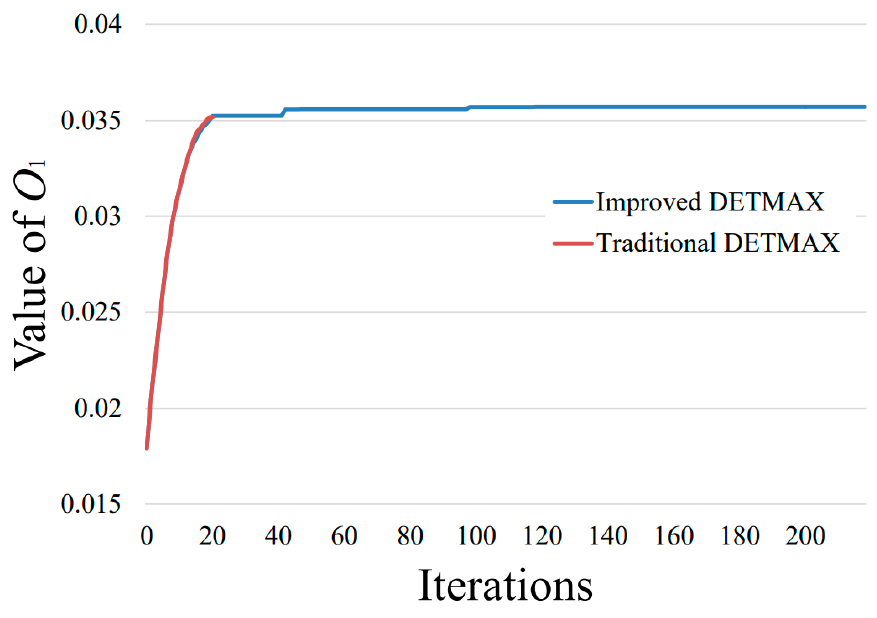
Figure 6. The process of measurement poses selection using improved DETMAX algorithm and traditional DETMAX algorithm.